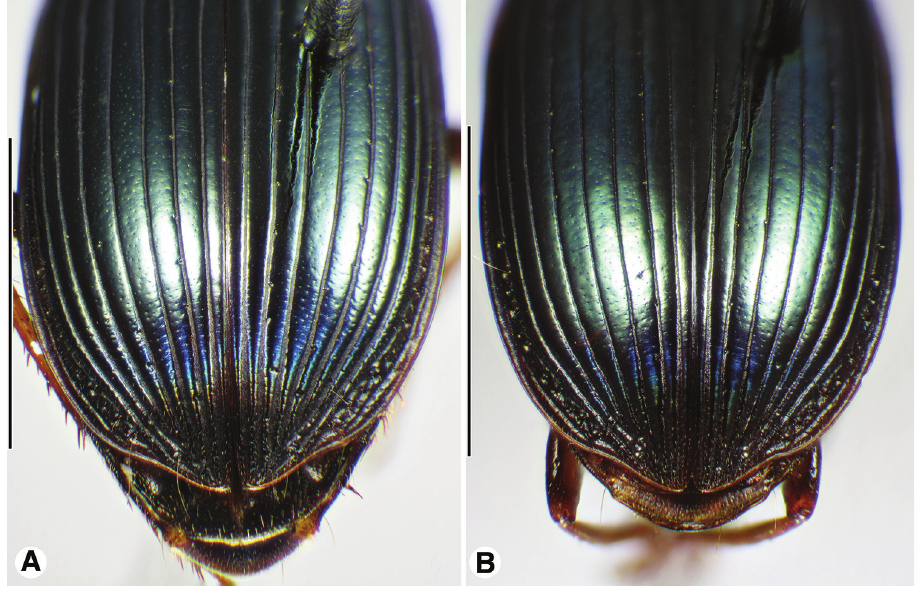
Figure 41. Digital images of apical portion of elytra of Selenophorus species, tilted dorsal aspect. A S. fabricii sp. n. B S. integer (Fabricius). Scale bars 3